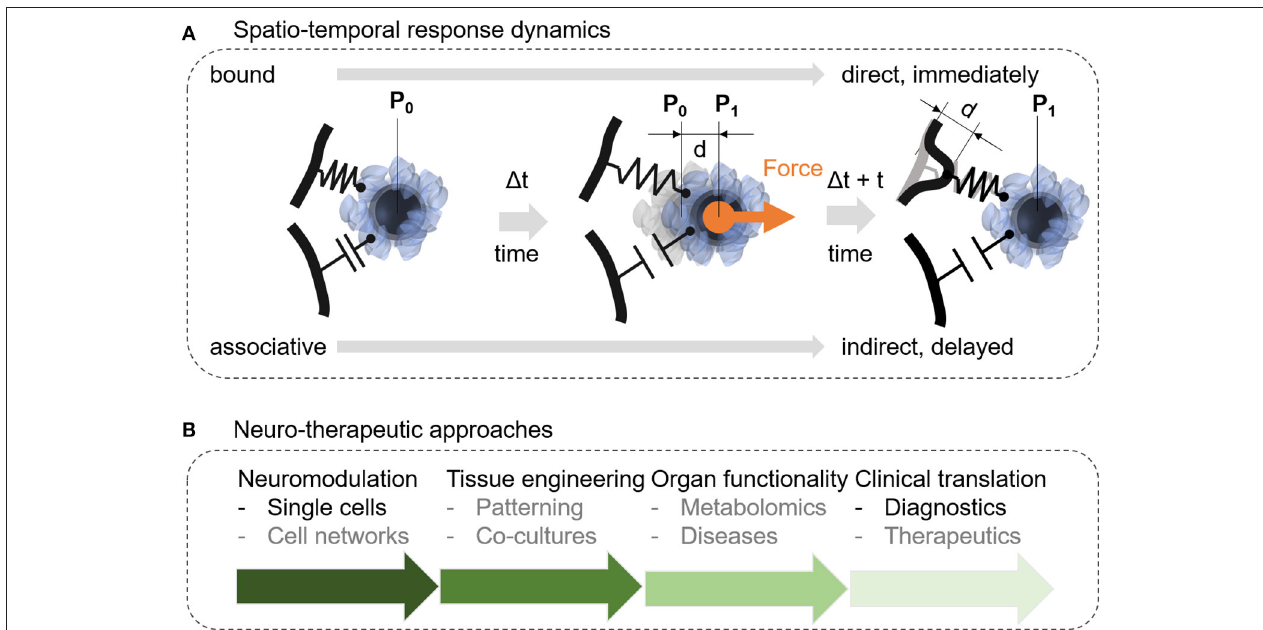
FIGURE 7 | Suggested future studies should address fundamental aspects of how nanomagnetic forces associate with cellular structures or how nanomagnetic force stimulation can be integrated into therapeutic and translational approaches. (A) Protein-protein interactions are suggested to play a dominant role in nanomagnetic force activation and may determine how much force is required and how sensitive cells are to a biomechanical stimulus at the membrane. Depending on the surface functionality nanoparticles may interact with the cellular membrane in a weak associative or on a strong bound connection. The strong bound connection suggests an immediate deformation of the membrane resulting in a short lag time to trigger a specific intracellular downstream process after a stimulus occurred. In contrast to the strong connection, the weaker associative connection may lead to a longer lag time or result in no further activation of downstream processes. (B) Other research efforts should focus on integrating nanomagnetic force stimulation into current neuromodulation tools, tissue engineering, organ functionality and translation into diagnostics, patient-specific therapeutics, or treatment